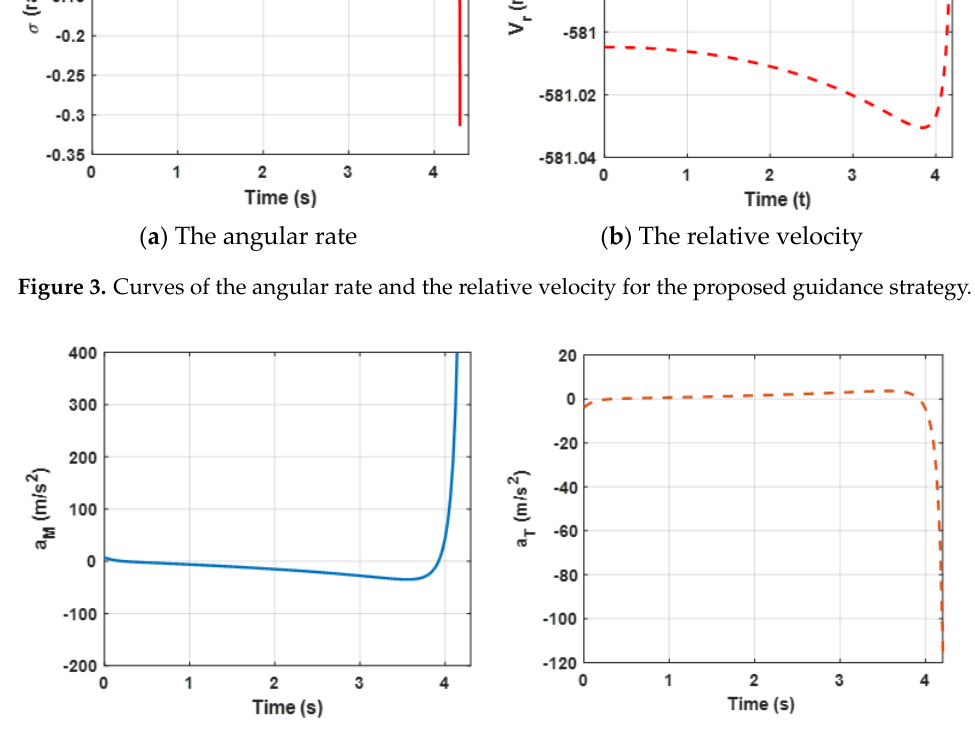
Figure 4. Acceleration demand of the missile and the target for the proposed guidance strategy.